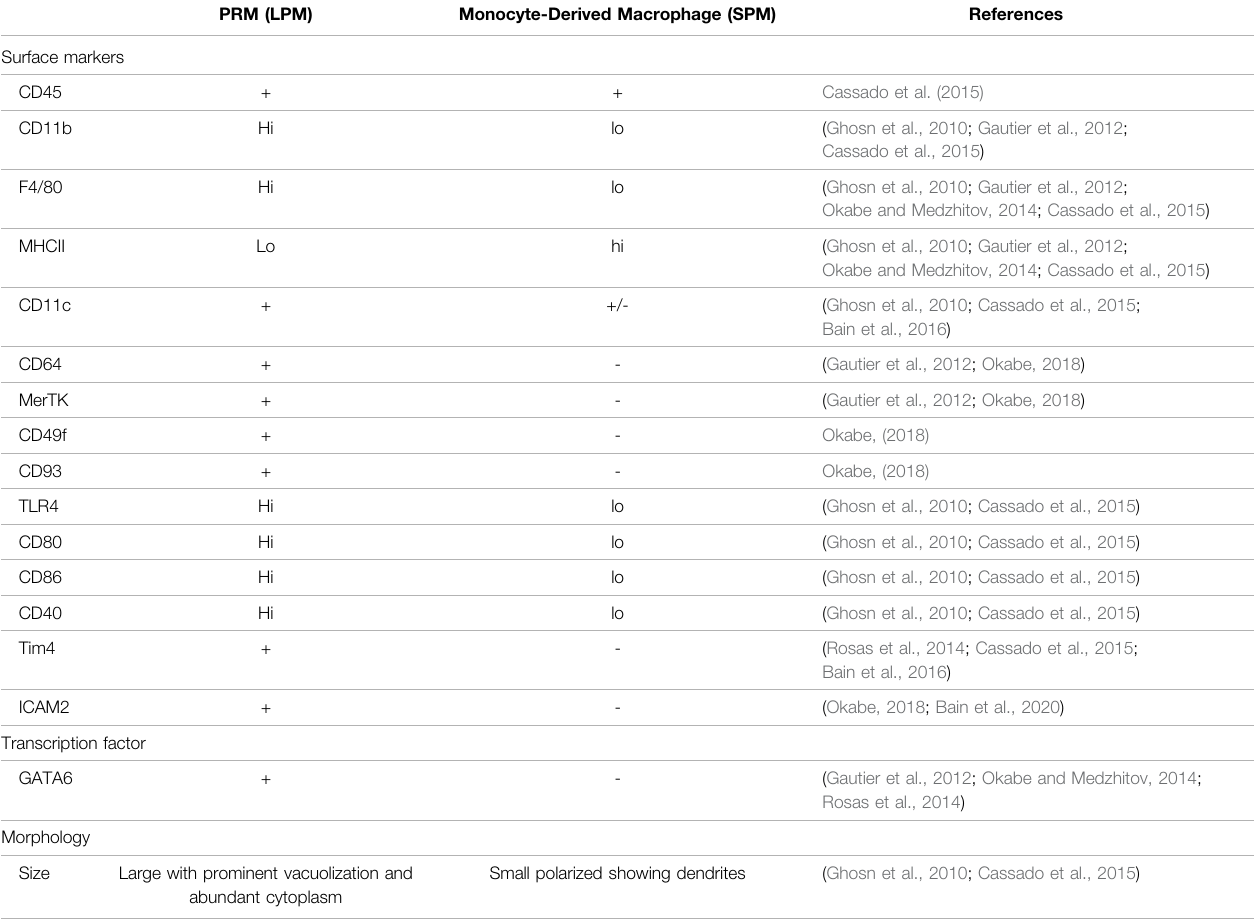
TABLE 1 | Characteristics of PRM in